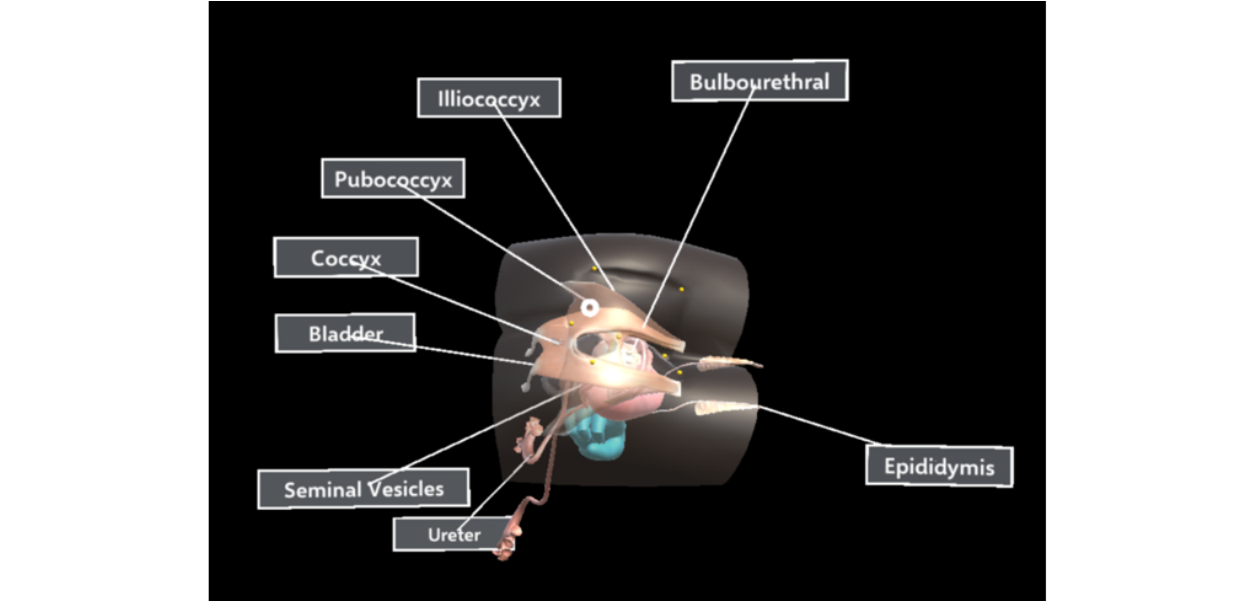
Figure 12. Occlusion between labels is resolved by pushing them apart along the circumference of the sphere, whose center is at the center of mass of the benchtop model.